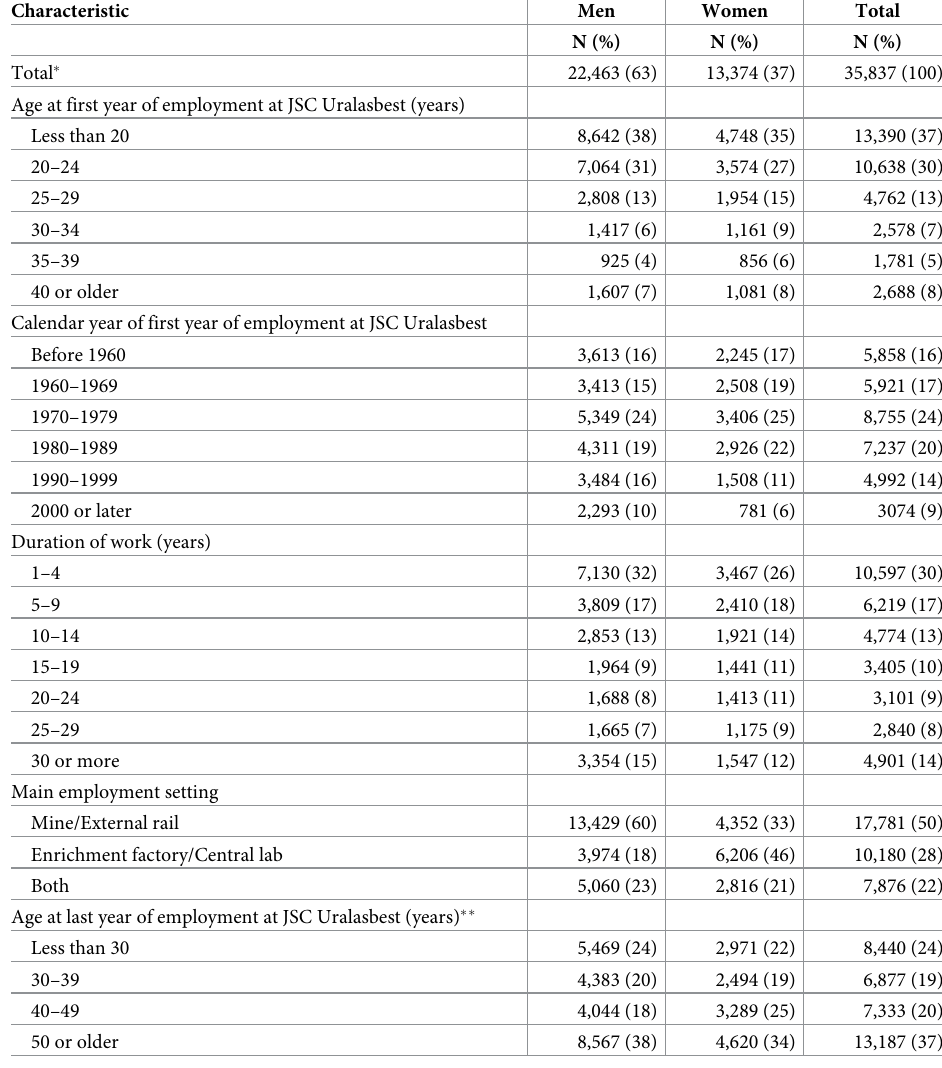
� Row percentage for men and women for Total, otherwise column percentage �� Irrespective of reason for leaving (e.g., retirement, dismissal,